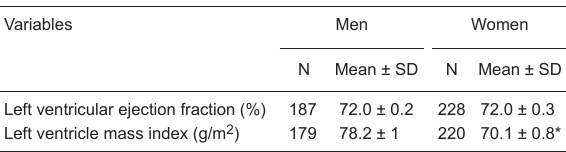
Table 3. Echocardiogram characteristics of the men and women of the study sample. Variables